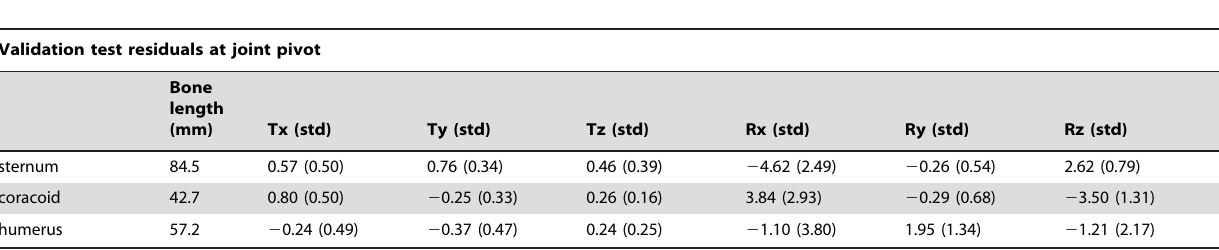
Table 3. Translation and rotation residuals (mean followed by standard deviation in parentheses) at joint pivots comparing rotoscoped bones to marker driven bones.